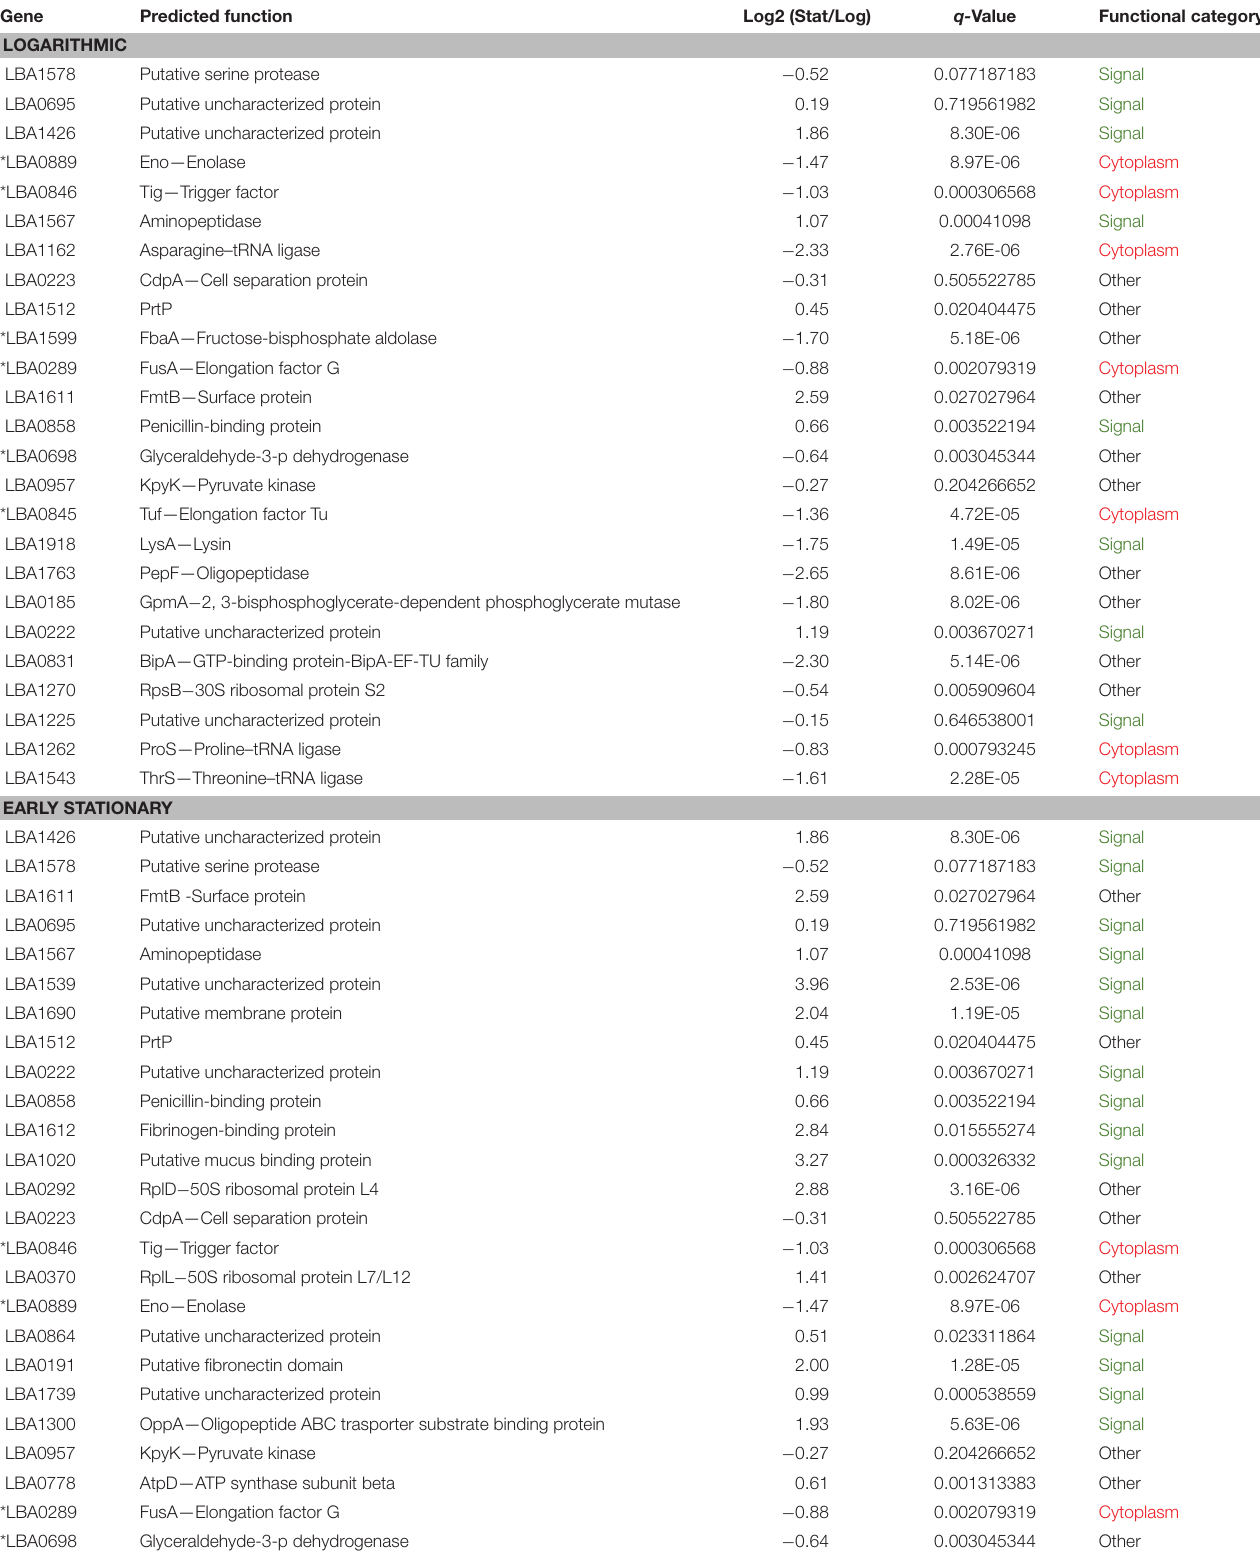
TABLE 1 | The 25 most abundant S-layer associated proteins in logarithmic phase and early stationary phase. Gene